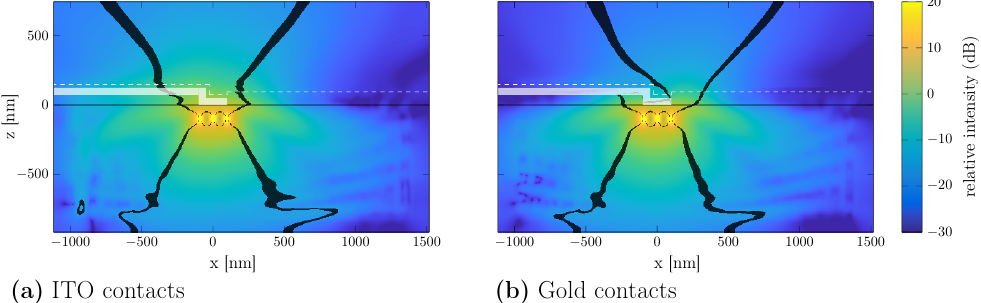
Figure 5. Relative intensity of the electromagnetic field intensity in the xz plane for the double-line design, given in dB where 0 dB corresponds to the maximum intensity on the xy plane for ITO contacts in Figure 2. ( a ) Intensity distribution for ITO contacts. ( b ) Intensity distribution for gold contacts. The thick black lines indicate the isolines at half of the maximum intensity. The three bright dots correspond to the positions of the central three dipoles of the 3 3 dipole array to approximate × the distributed light source. The metallization is shown as shaded light areas, the thin black line indicates the GaN surface and the dashed white line indicates the SiO 2